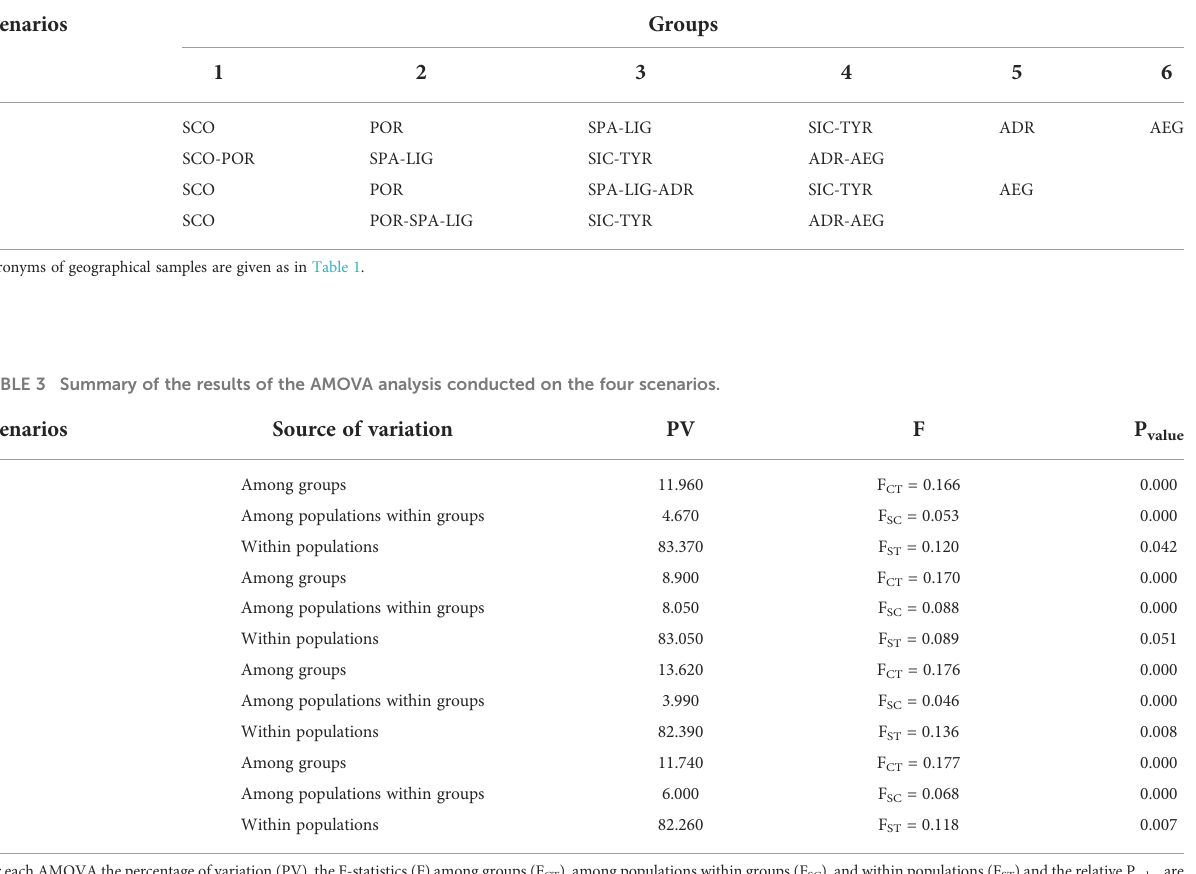
TABLE 2 Summary of a priori groupings tested by AMOVA analysis according to the geographic origin of the individuals.